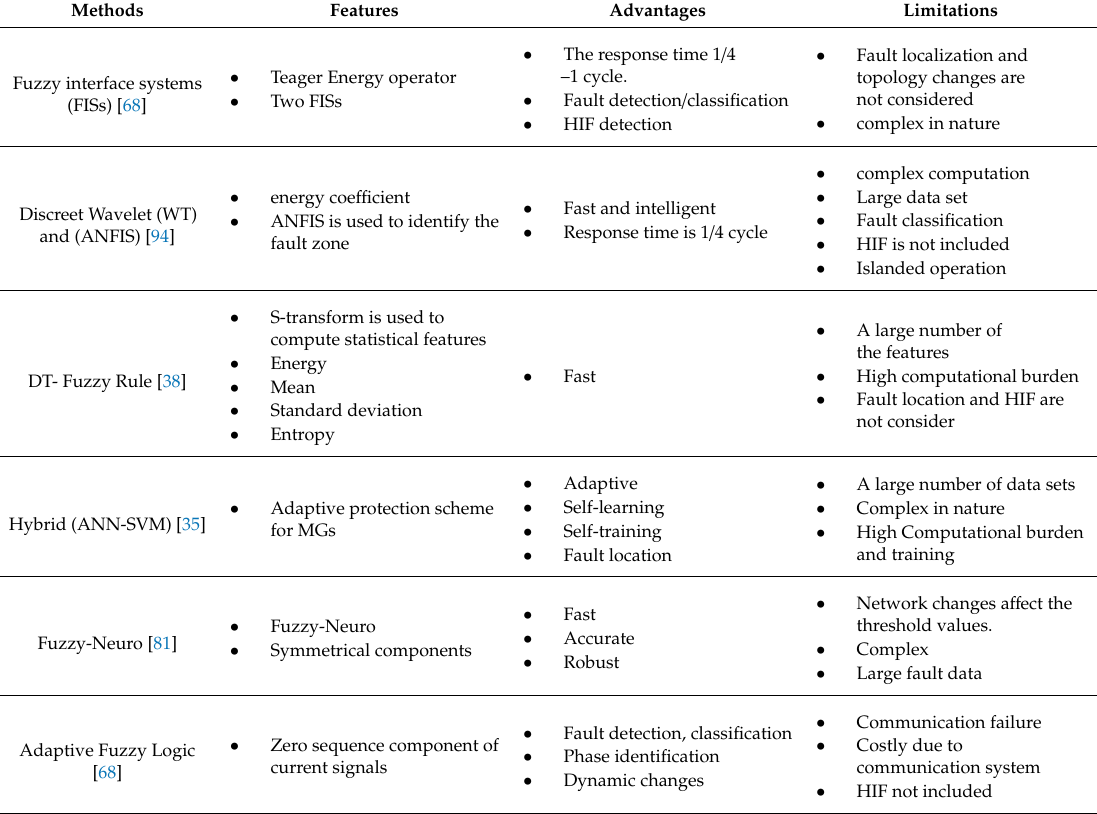
Table 3. Artificial Intelligence (AI) and Machine learning (ML) -based fault detection and fault classification